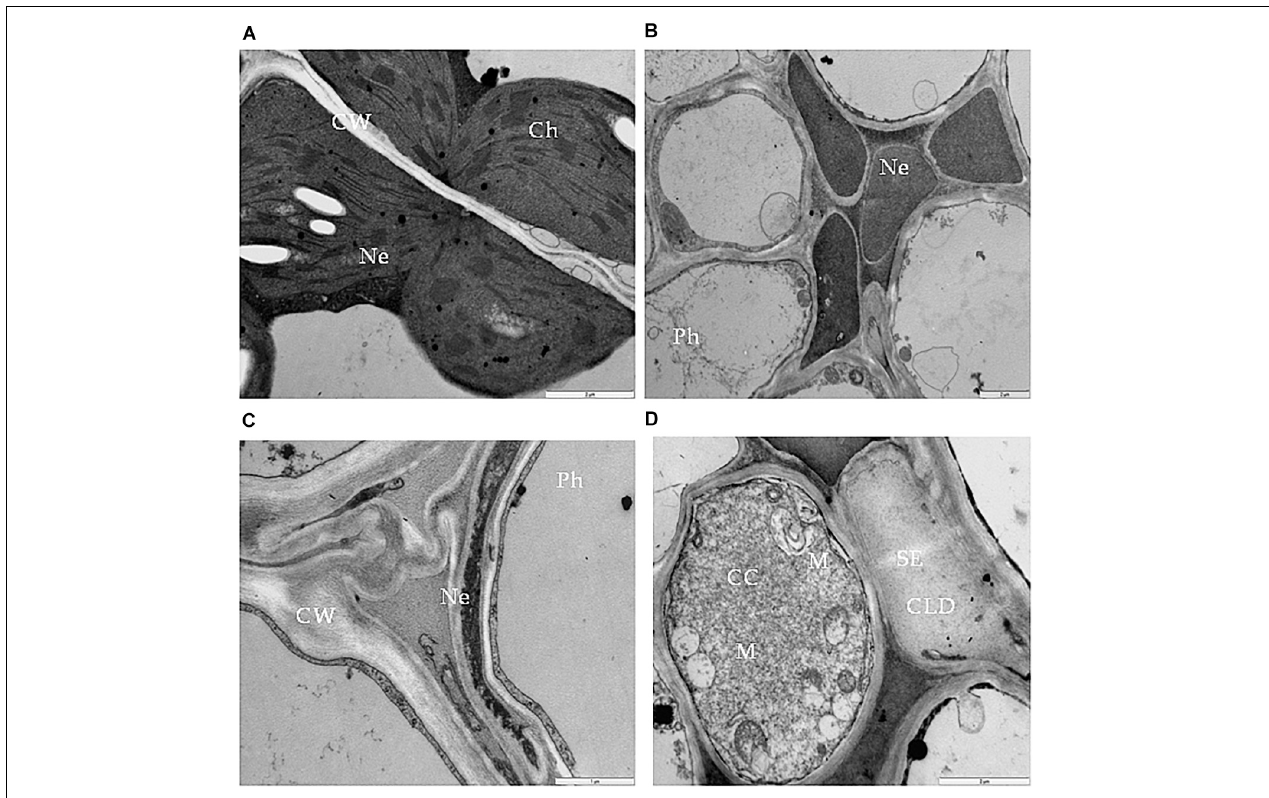
FIGURE 2 | Necrosis in bell pepper tissues infected with BPEV. (A) Necrosis (Ne) of palisade mesophyll cells. Bar 2 µ m. (B) Necrosis (Ne) in phloem (Ph) elements. Bar 2 µ m. (C) Collapsed sieve element and necrosis of companion cell (CC). Bar 2 µ m. (D) Sieve element (SE) filled with callose like deposition and companion cell (CC) with expanded mitochondria (M). Bar 2 µ